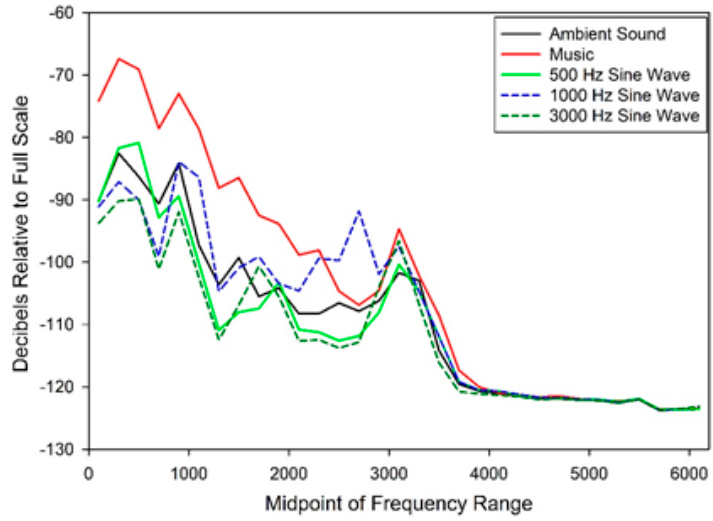
Figure 3. Audio spectra averaged every 200 Hertz for primary sound-treated anaerobic digesters exposed to various audio files. Peak audio intensities: ambient, − 64.9 dB at 321 Hertz and Beethoven Symphony No. 6, Movement 5, − 43.0 dB at 439 Hz. Sine waves: 500-Hertz sine wave, − 15 dB; 1000-Hertz sine wave, − 3.2 dB; and 3000-Hertz sine wave, − 33.3 dB.